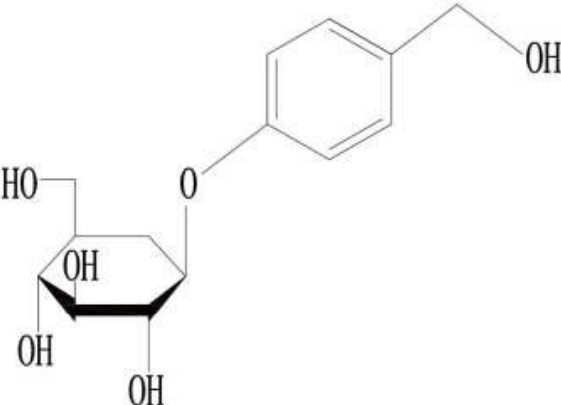
Figure 1. Chemical structures of gastrodin.